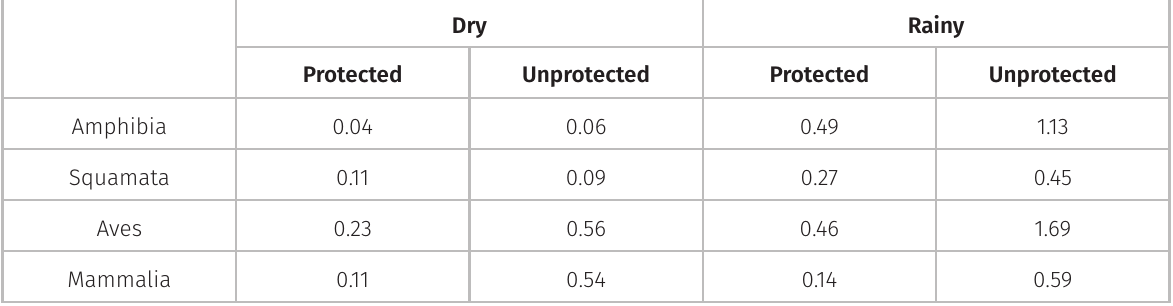
Figure 3. Rarefaction curves based on record abundance by taxonomic group (Amphibia, Squamata, Aves, and Mammalia) in each of the sampled landscapes (unprotected landscape: gray curve; and protected landscape: black curve). A 95% confidence interval for the sake of statistical comparison between curves is also shown as vertical lines. Table II. Roadkill rates (individuals/Km/day) per taxonomic group, between seasons (rainy and dry), and landscapes (protected and